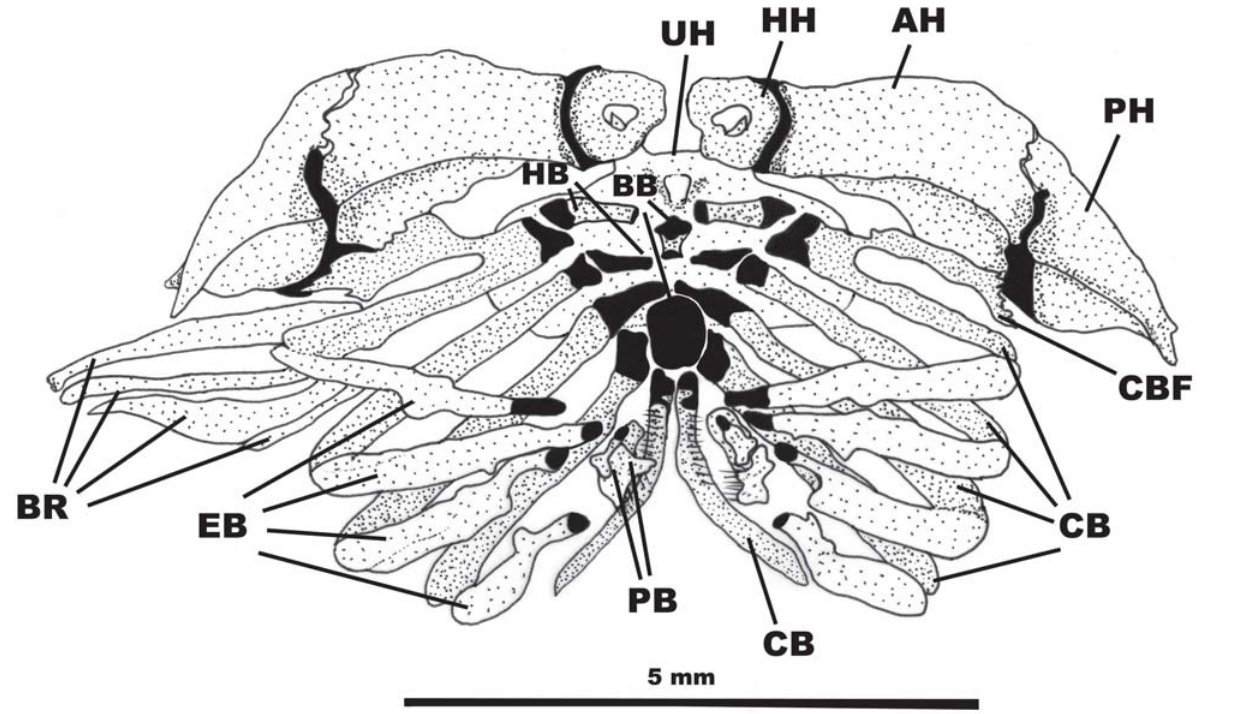
Fig. 10. Branchial skeleton in dorsal view of Gymnotocinclus anosteos , MCP 41726, paratype, male, 40.5